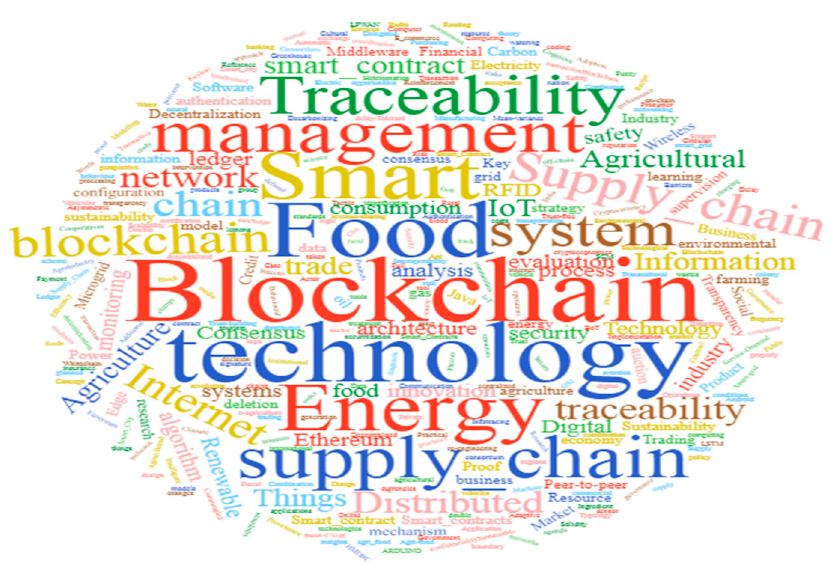
Figure 4. Word cloud of the most frequent keywords in the 71 articles on blockchain in agribusiness.